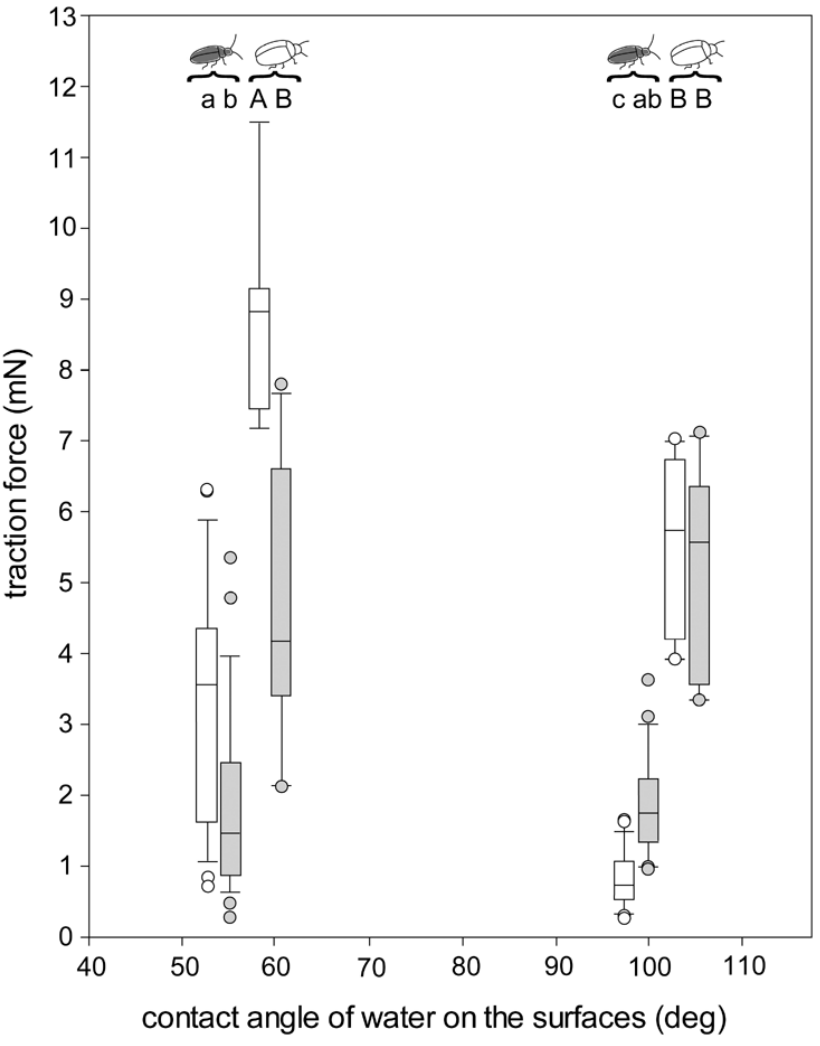
Figure 5. Traction forces of G. nymphaeae on different surfaces in air and underwater. For comparison, data for G. viridula are added from [10]. The plots show the medians (lines within the boxes), 25th and 75th percentiles (ends of boxes), 10th and 90th percentiles (error bars), and outlying values. White boxes and circles: in air; grey boxes and circles: underwater. Different letters above two boxes (separately within small letters and within large letters) indicate significant differences between two groups (multiple pairwise comparisons). Pairs of boxes at 54° and 99° (black beetle icon): Galerucella nymphaeae . Pairs of boxes at 59° and 104° (white beetle icon): Gastrophysa viridula . Each beetle ( n = 33 for G. nymphaeae , n = 29 for G. viridula ) was tested once in air and once underwater; two of these G. nymphaeae beetles were solely tested in air. Different letters (a, b or A, B) indicate statistically significant difference between samples.